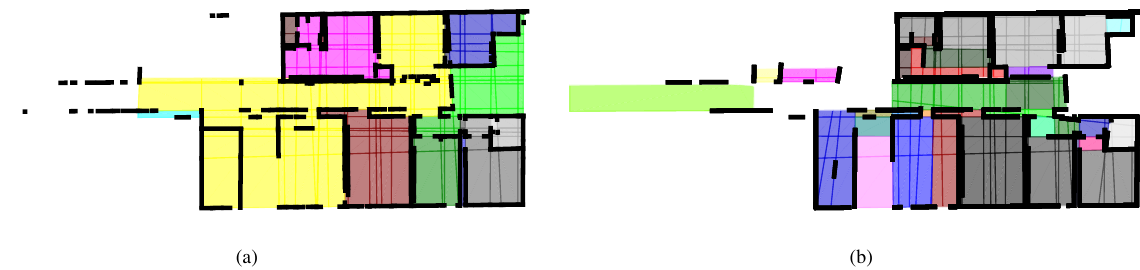
Figure 9. Dataset TUB2 (first floor): floor plans obtained with (a) the proposed method and (b) the method by (Magri and Fusiello, 2018). This figure is best viewed in colours.